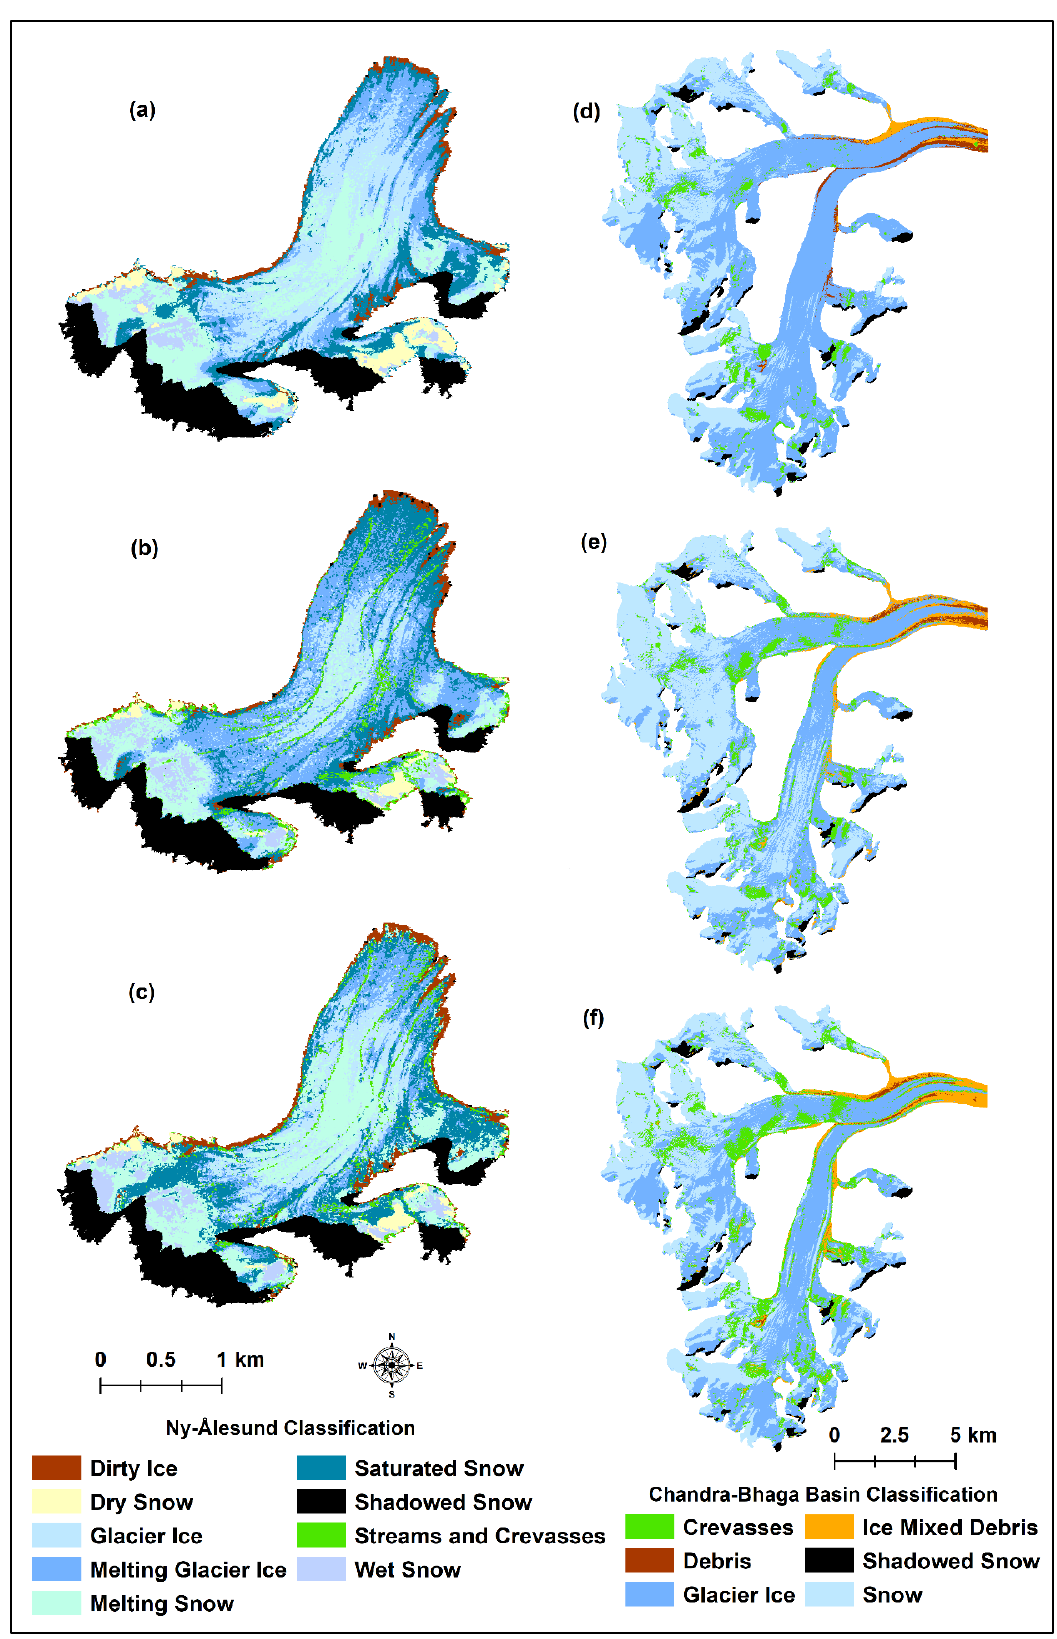
Figure 5. Classification results of the best rule sets from both study sites. Ny-Å lesund classification: